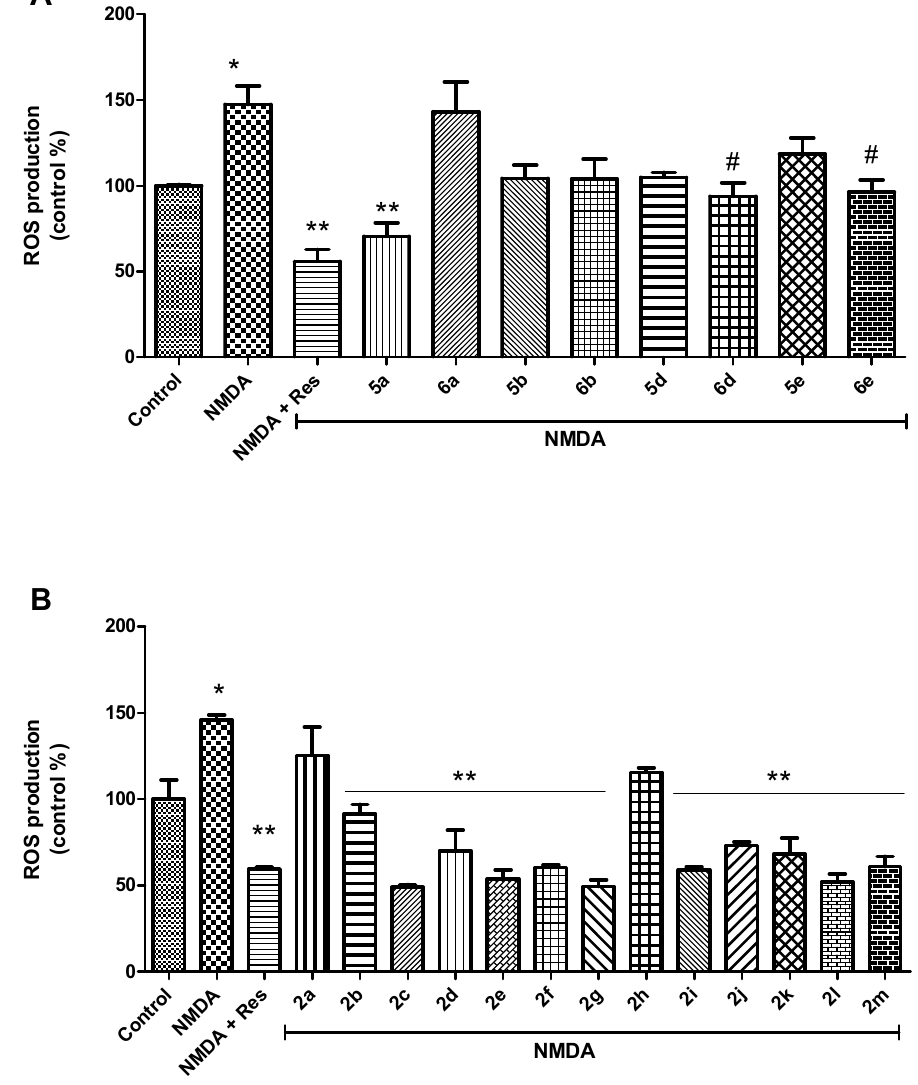
Figure 1. The alteration in ROS production following ( A ) triazolo- and ( B ) amino-tomentosin treat- ments at indicated concentrations in NMDA (2 mM)-treated SH-SY5Y cells. The concentration of each derivative was 0.1 µ M, except for 2b , 2e , and 2g , whose concentrations were 1 µ M. * p < 0.05 significant difference from untreated cells; ** p < 0.01 significant difference from NMDA-treated cells; # p < 0.05 significant difference from NMDA-treated cells.